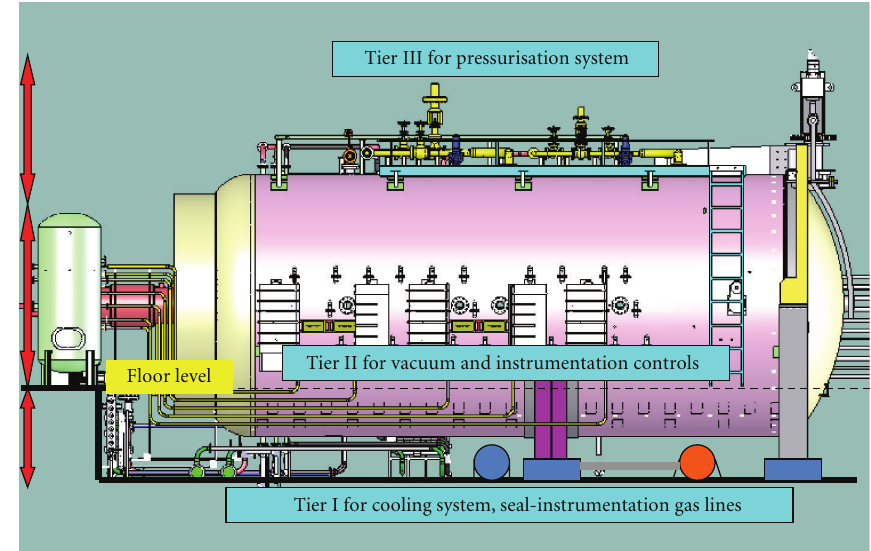
Figure 12: Three-tier layout of